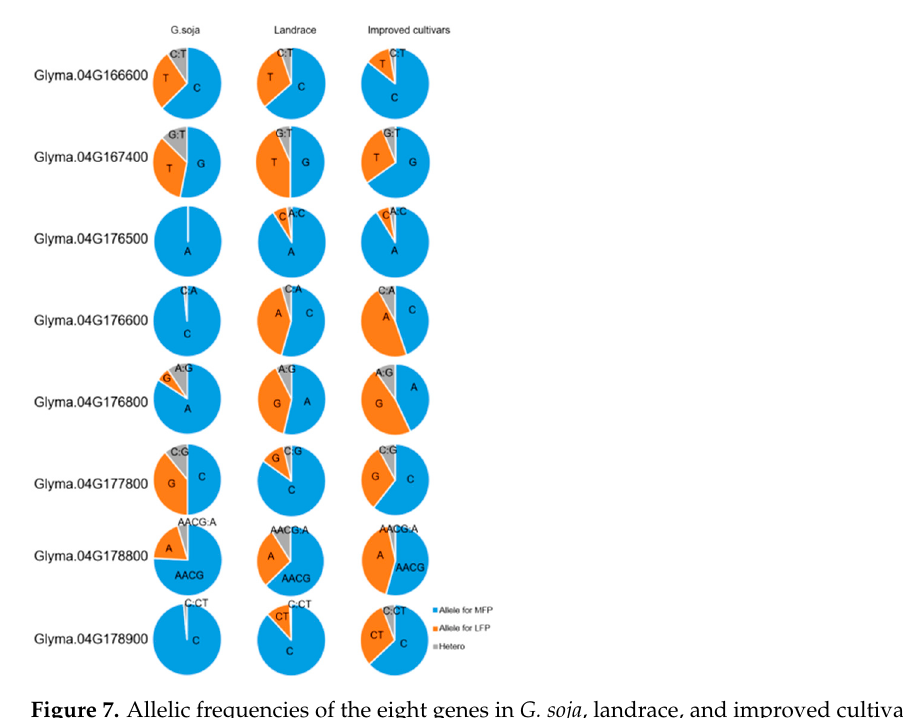
Figure 7. Allelic frequencies of the eight genes in G. soja , landrace, and improved cultivars. Table 4. Variation information and percentage of the eight genes in the population.